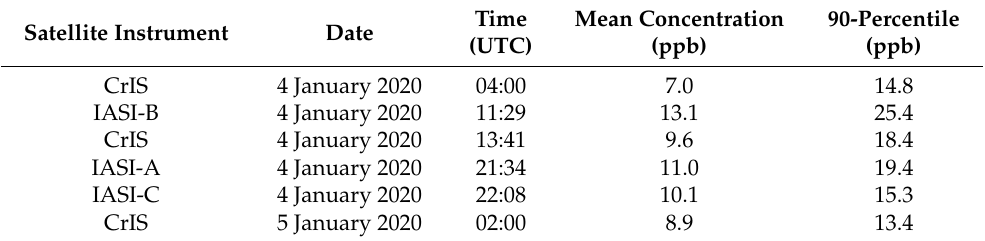
Table 2. HONO plume detected by CrIS and IASI instruments on 4 and 5 January 2020 between Southeast Australia and New-Zealand. The overpass time is indicated as well as the retrieved mean and 90-percentile concentrations. The values refer to the maximum of the HONO profile at 5 km. Satellite